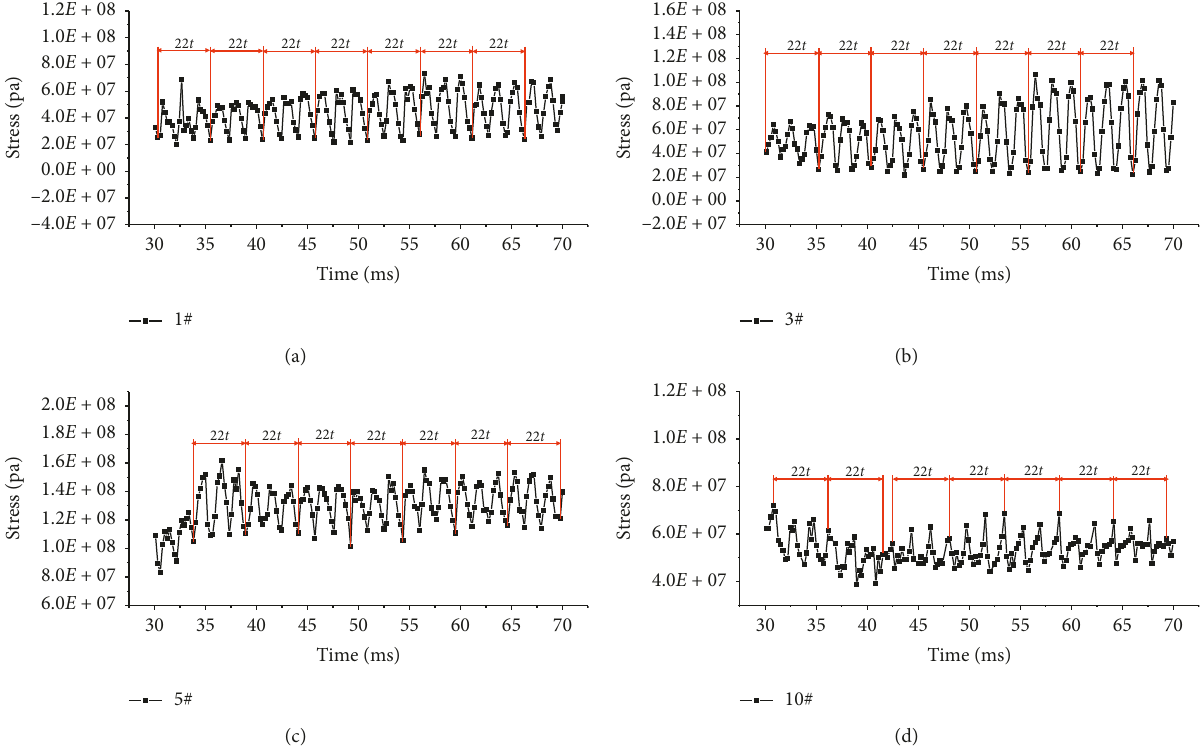
Figure 8: Stress fluctuation cycle period of the representative elements ( α � 10 ° , H � 10mm, and V � 0.46m/s): (a) 1# element; (b) 3# element; (c) 5# element; (d) 10#